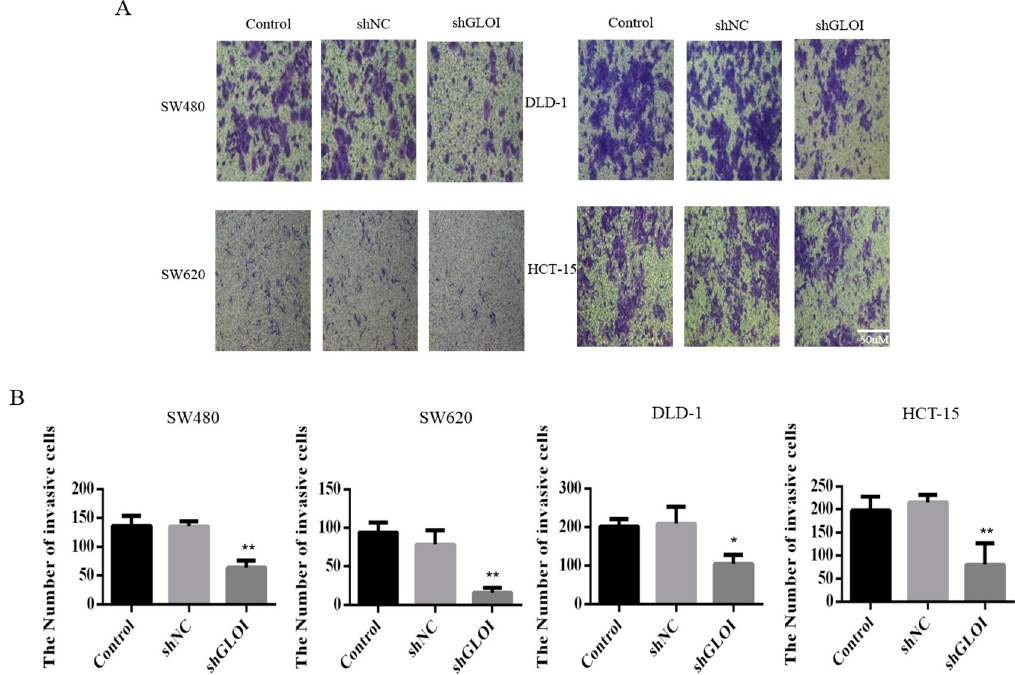
Figure 6. GLOI knockdown inhibits invasion by colorectal cancer (CRC) cells. ( A , B ) SW480, SW620, DLD-1, and HCT-15 CRC cells were transfected with shGLOI or shNC (empty vector) and their invasiveness evaluated by their penetration of a transwell insert membrane coated with matrigel. * p < 0.05, ** p < 0.01. All data are representative of three independent experiments ( n = 3).